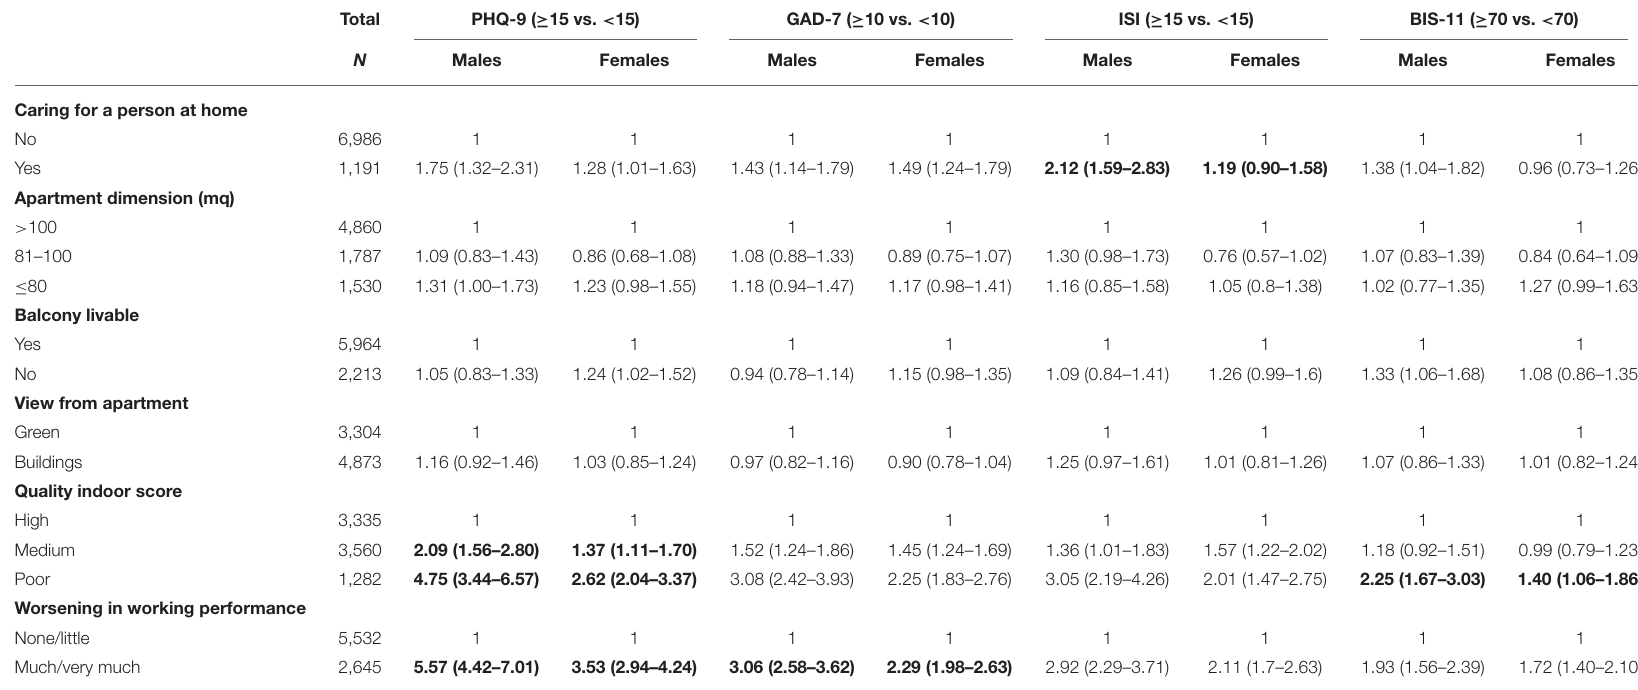
TABLE 2 | Odds ratio* (OR) and their 95% confidence intervals (CI) for symptoms of depression [nine-item Patient Health Questionnaire (PHQ-9) ≥ 15], anxiety [seven-item Generalized Anxiety Disorder (GAD-7) ≥ 10], insomnia [Insomnia Severity Index (ISI) ≥ 15], and impulsivity [Barratt Impulsiveness Scale-11 (BIS-11) ≥ 70] according to selected factors, in males and females, separately. Total PHQ-9 ( ≥ 15 vs. < 15) GAD-7 ( ≥ 10 vs. < 10) ISI ( ≥ 15 vs. < 15) BIS-11 ( ≥ 70 vs. <